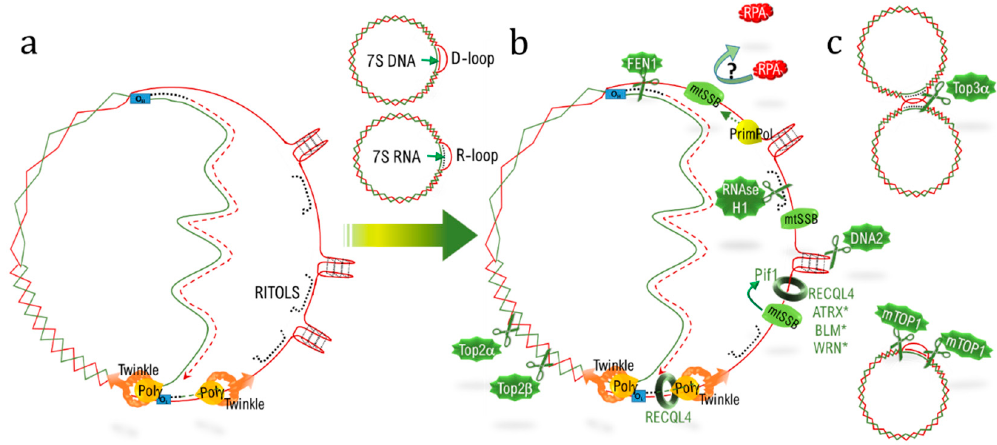
Figure 2. Obstacles and solutions during mtDNA replication. ( a ) The mitochondrial replisome (Pol γ , Twinkle) replicates the leading strand (dotted red line) complementarily to the light strand (green line) until it frees the O L enabling the replication of the lagging strand (doted green line). The freed lagging strand (in red) forms the G4 and R-loop (in agreement with the RITOLS replication mode, with RNA depicted in dotted dark lines). ( b ) Numerous factors allow for an accurate replication, by cleaving (DNA2) or unwinding G4 (Pif1, RECQL4, ATRX, BLM, WRN); by suppressing RNA:DNA hybrids (RNAse H1, FEN1), or by alleviating torsions (TOP2a, TOP2b, mTOP1, TOP3a). mtSSB stabilizes the single-stranded H-strand and stimulates Pif1 helicase activity. ( c ) Top3a decatenates the two copies of mtDNA resulting from the replication and mTOP1 reduces supercoiling surrounding the